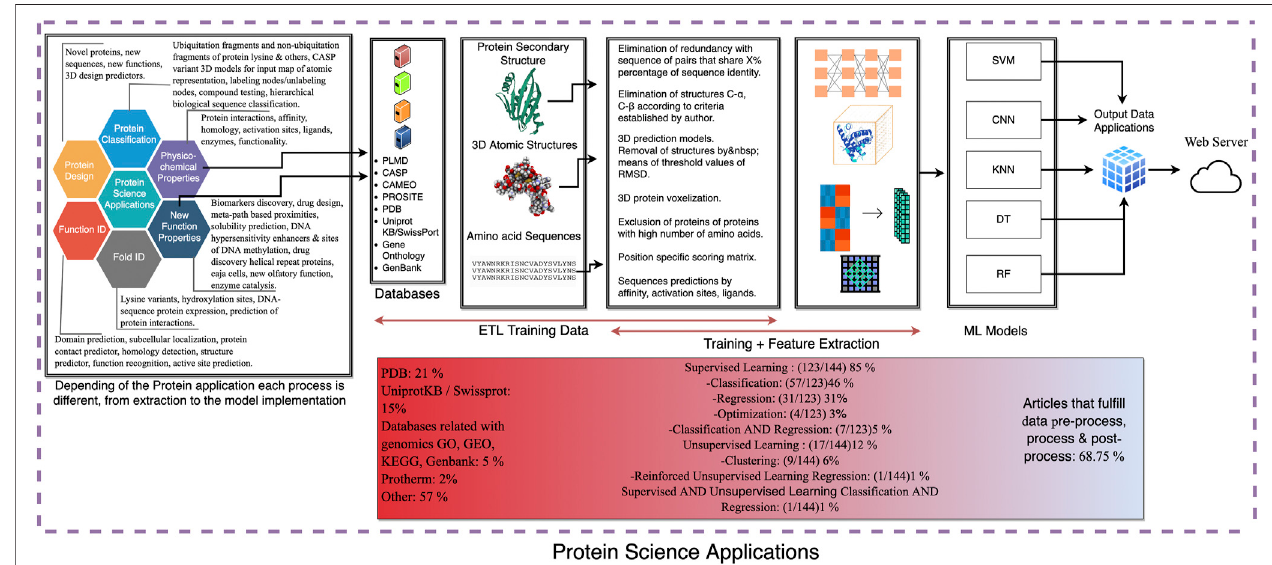
FIGURE 7 | Representation of the whole AI process based on the selected protein application. The process amalgams several steps: protein application (protein design, protein classi fi cation, protein prediction, etc .), extraction (selection of database), transform (code development and fi ltering), and load (input of the training data) (ETL) for the training data and the feature extraction procedure is the building of the machine learning network. Outcome step and a proposal server application.